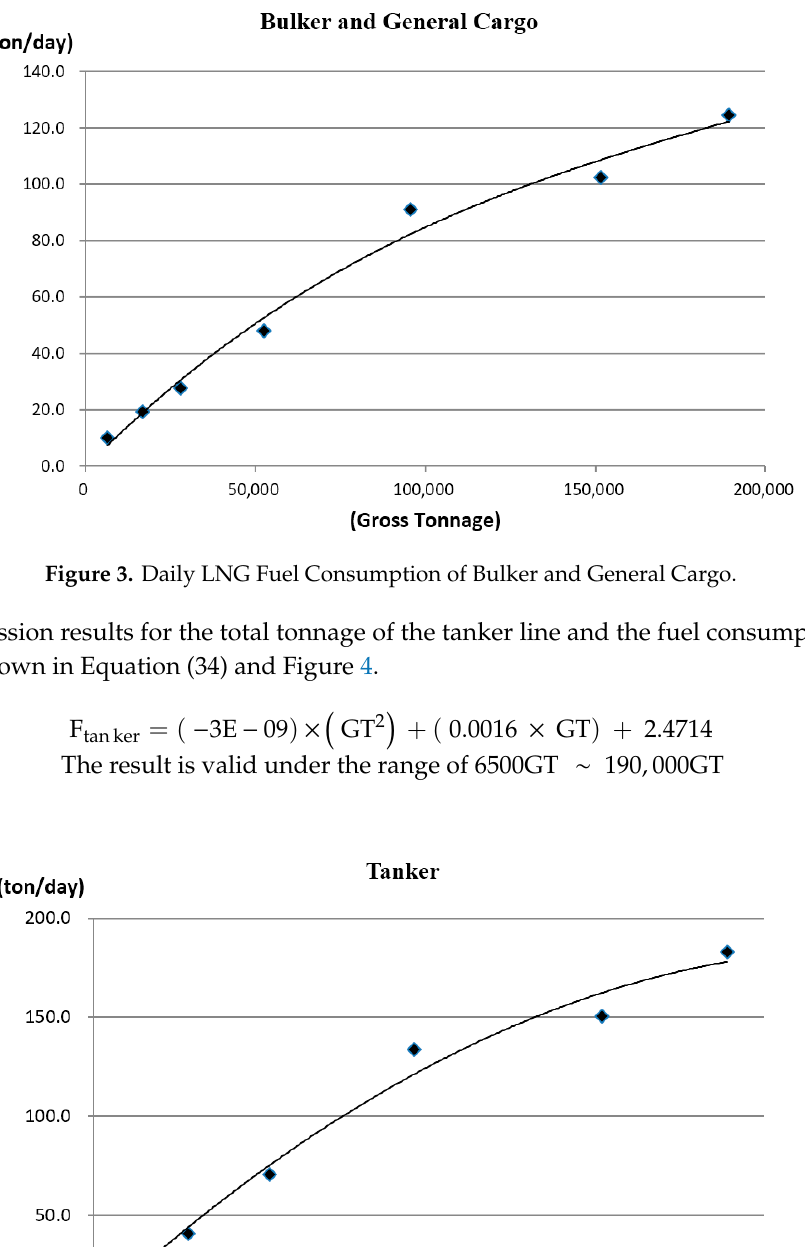
Figure 5. Daily LNG Fuel Consumption of Cruiser. 4. Case Study: LNG Bunkering Environment of Busan Port 4.1. Analysis of Vessels Entering the Port of Busan The PORT-MIS data of the Port of Busan was used for the analysis of 27,310 vessels for 1 year from January 1, 2018, to December 31, 2018 [25]. In the PORT-MIS, 5 types of vessels (bulkers, tankers, containers, general cargo ships, and cruisers) were analyzed.